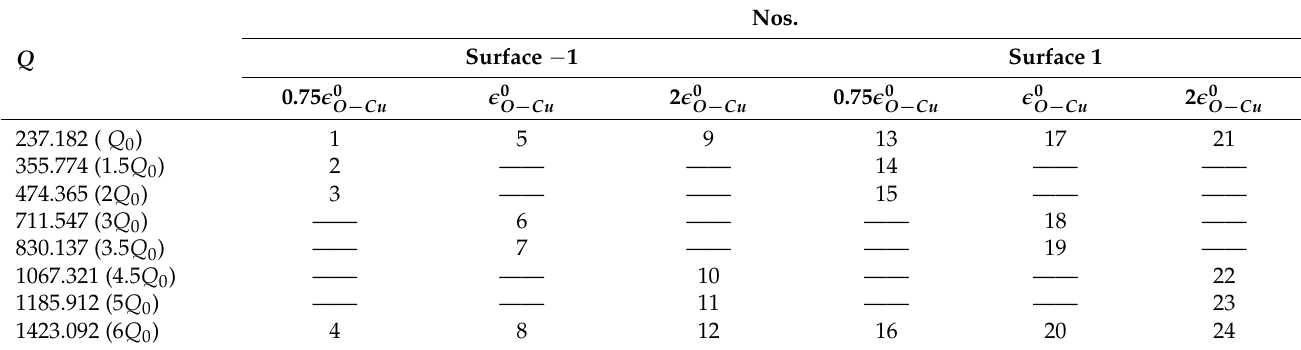
Table 3. Simulation case Nos. in